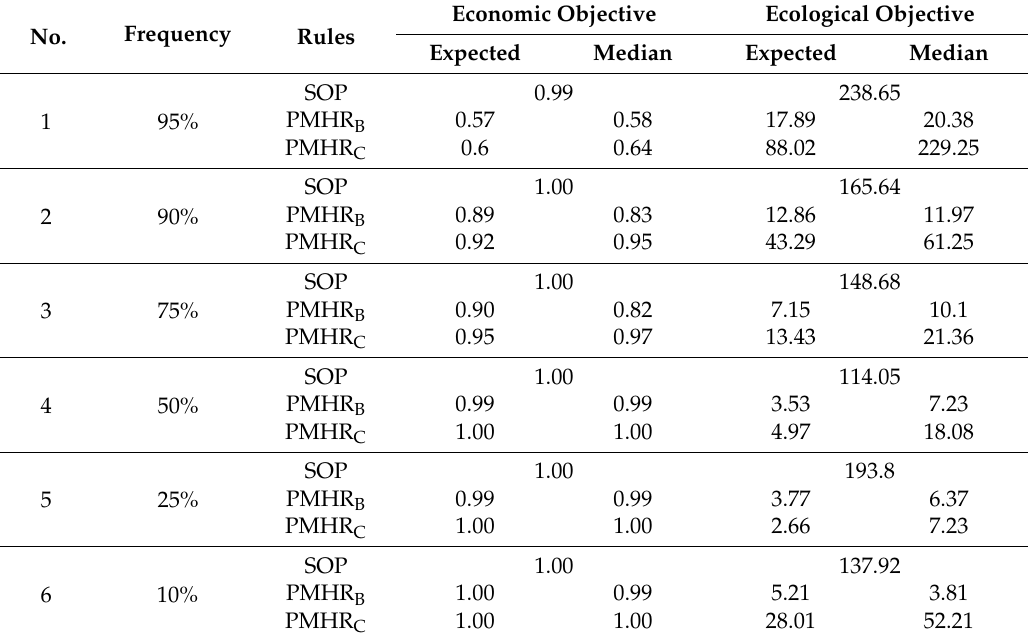
Table 5. Comparison of economic and ecological